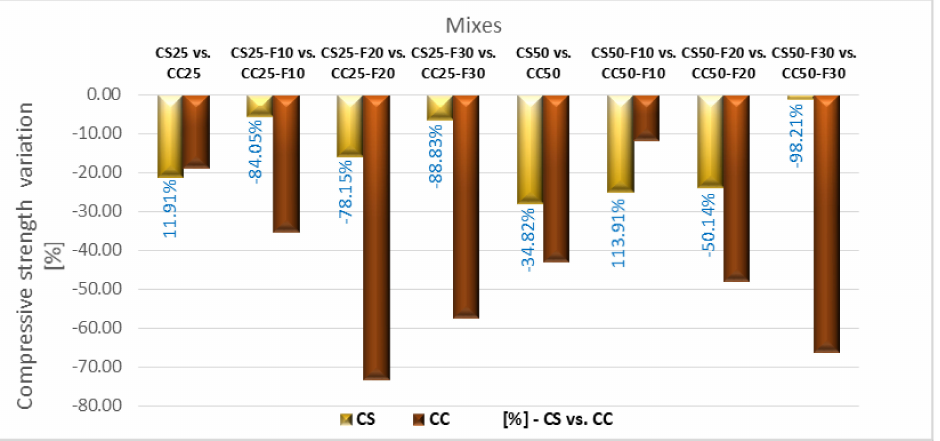
Figure 24. Variation of compressive strength loss of composites with sunflower aggregates versus composites with corn cobs aggregates, after 50 freeze-thaw cycles